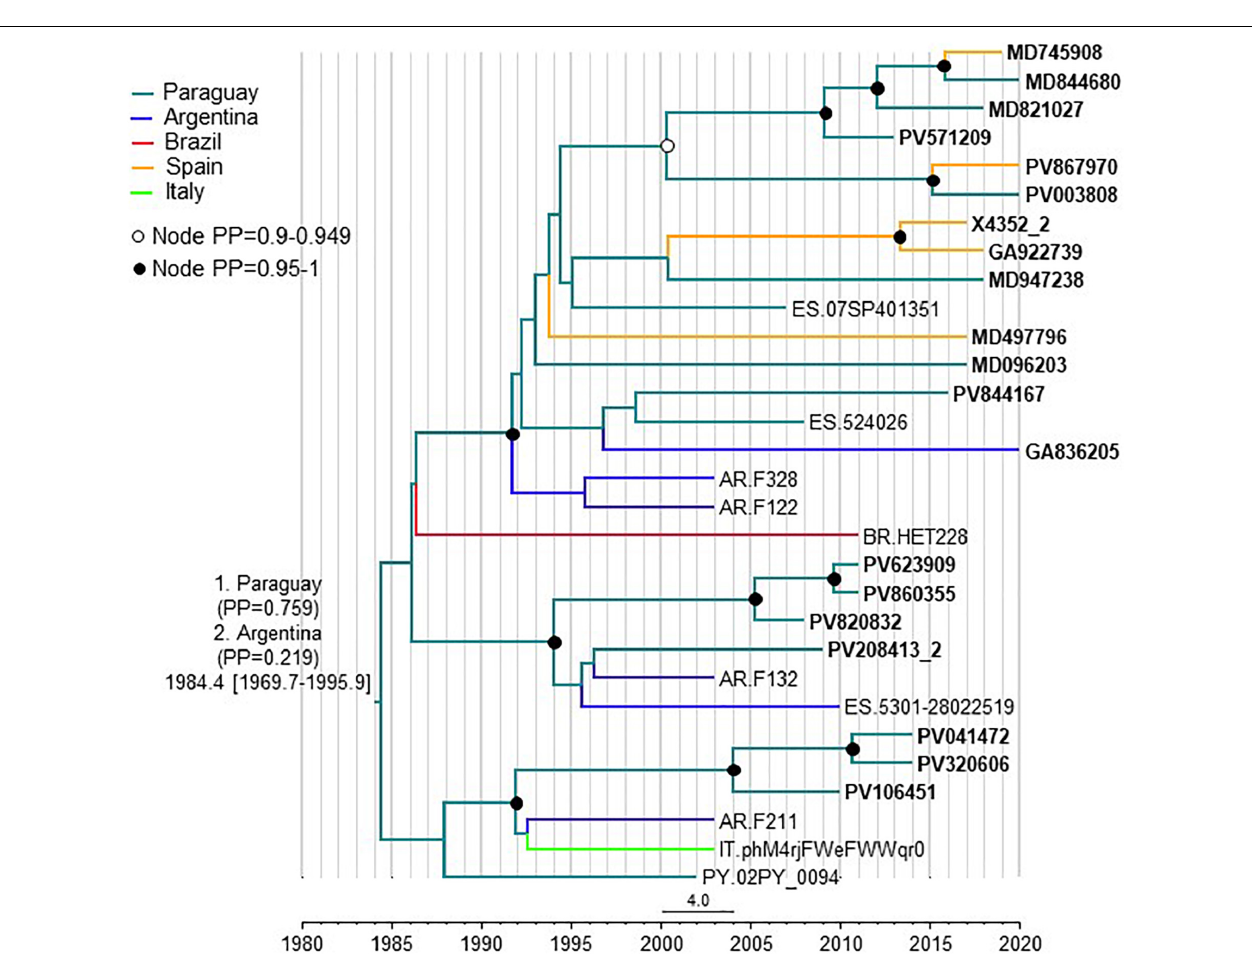
FIGURE 6 | Maximum clade credibility tree of CRF66_BF Pr-RT sequences. Branch colors indicate, for terminal branches, country of sample collection or, for South American individuals residing in Spain, of origin of the individual, which was used as location trait (see Methods), and for internal branches, the most probable location country of the subtending node, according to the legend on the upper left. For database sequence 524026, from a sample collected in Spain, location was assigned to Paraguay as the most probably country of origin, although the only available information in the GenBank entry is that the individual was from Latin America, because 15 (88.2%) of 17 Latin Americans with CRF66_BF sampled in Spain were from Paraguay. Nodes supported by PP ≥ 0.95 and PP 0.9–0.949 are indicated with filled and unfilled circles, respectively. The two most probable countries at the root of the tree are indicated, together with the PPs supporting each location and the time of the MRCA (mean value, with 95% HPD interval in